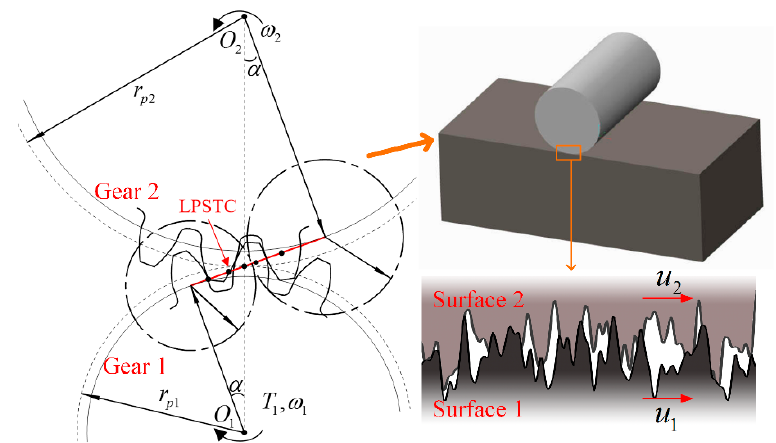
Figure 1. The schematic diagram of line contact.